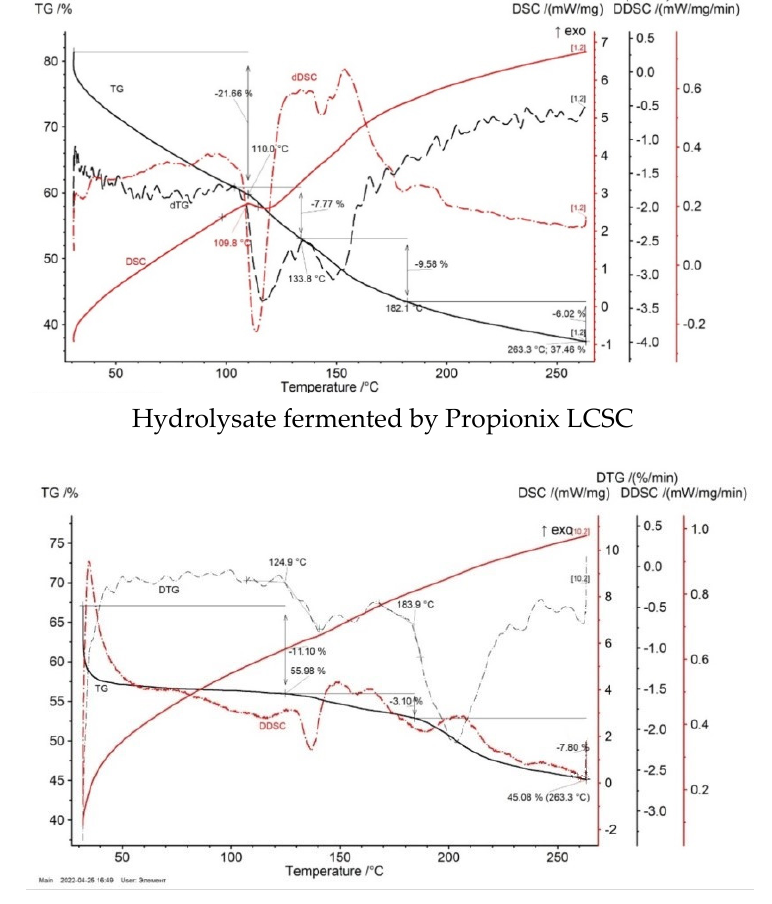
Figure 2. Dependences of sample mass change (TG), mass change rate (DTG), temperature (DSC), and temperature change rate (DDSC) measured by thermal gravimetric and differential-scanning calorimetry analysis.